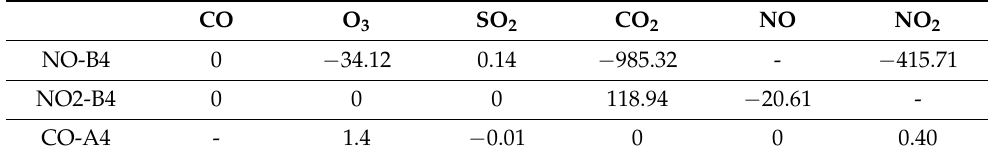
Table 2. Impact of co-pollutants on sensor signal when measuring a pollutant mix with pollutant concentrations typical for European suburban levels, expressed in percentages. Adapted from Lewis et. al. (2016) [10]. CO O 3 SO 2 CO 2 NO